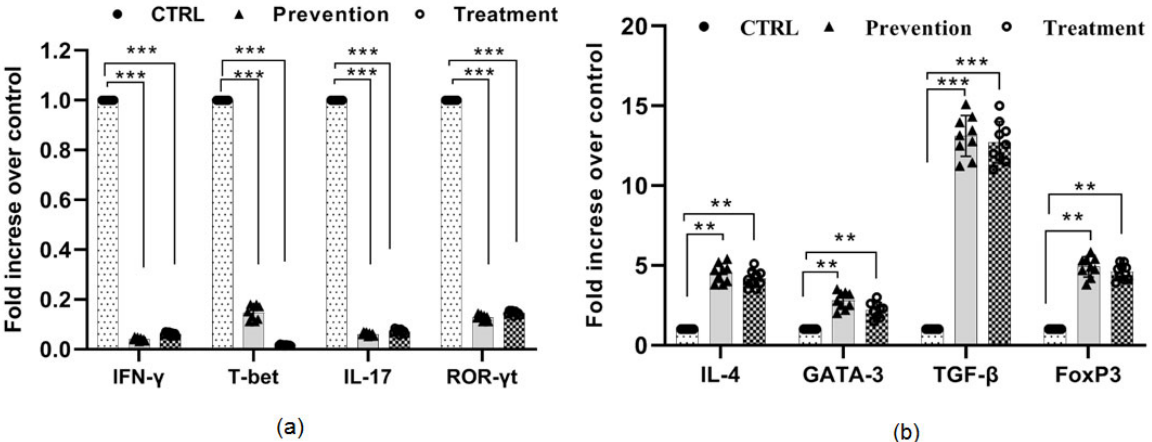
Figure 5. Gene expression of cytokines and transcription factors in CNS. On day 25 post- immunization, brains and spinal cords were collected, and mRNA levels of cytokines and tran- scription factors were assessed by real-time quantitative PCR. The assay was run in triplicates, fold change expression of genes was determined, and then compared to the control group. ( a ) Th1- and Th17-related cytokines and transcription factors IFN- γ , T-bet, IL-17, and ROR- γ t; ( b ) Th2- and Treg- related cytokines and transcription factors IL-4, GATA3, TGF- β , and FoxP3. Results were expressed as fold change normalized to the control group. ** p < 0.01, *** p < 0.001. Mice were divided into three groups: 1. Control group (CTRL, n = 9); 2. Prevention group with MOG (n = 9); 3. Treatment group with MOG (n = 9).